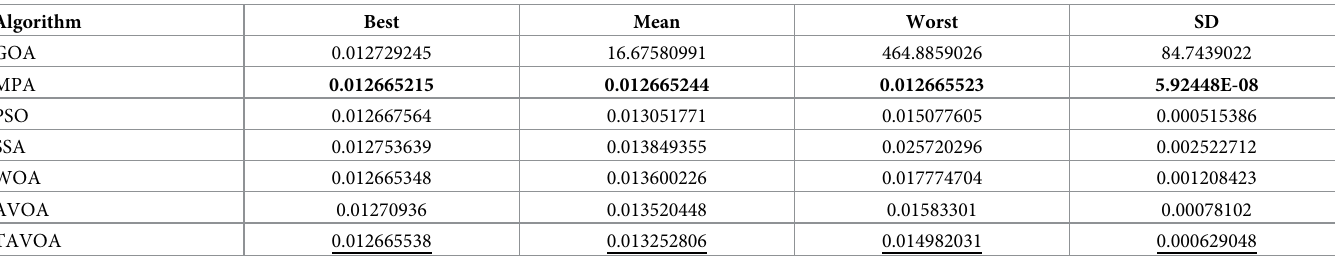
and comparison algorithms in the pressure vessel design problem are shown in Table 16. Table 14. Statistical results of tension/compression spring